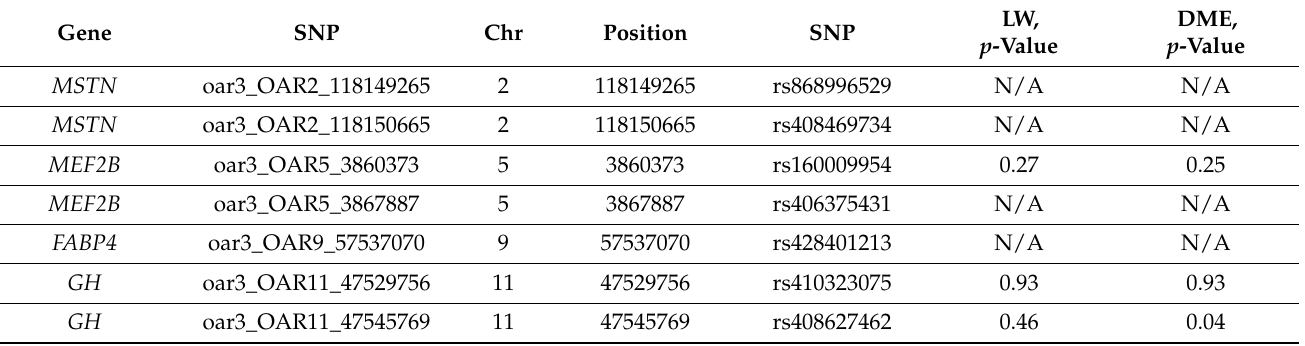
Table 1. SNPs in genes with no associations of meat production parameters in Jalgin